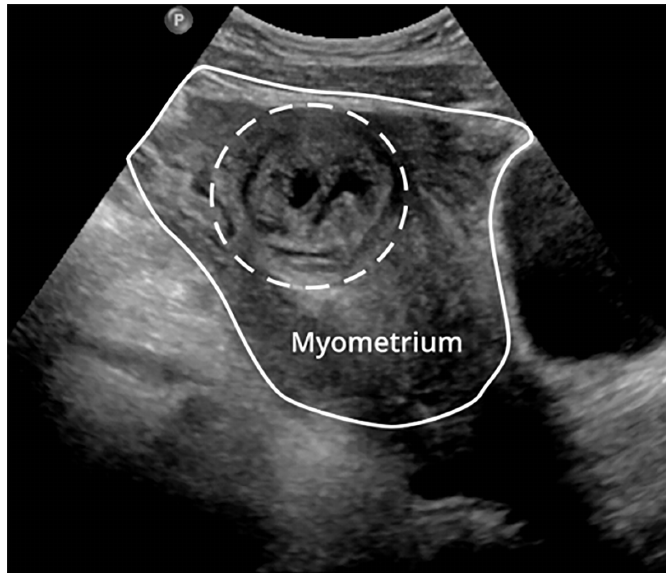
Image 2. Transabdominal ultrasound demonstrating a mass in the left lateral uterus (dashed circle).